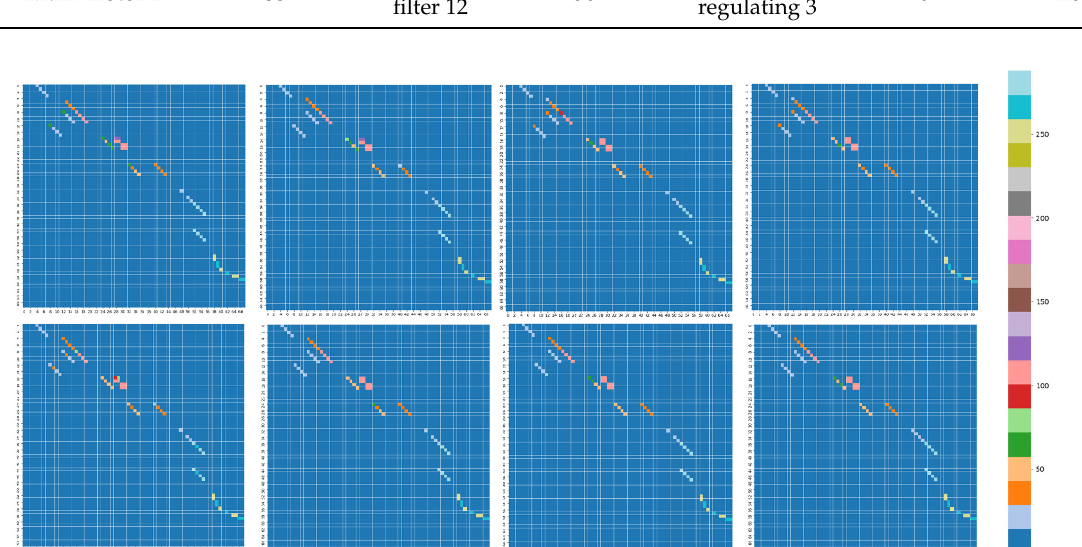
Figure 11. Schematic graph of a cluster of associated fault mode results.